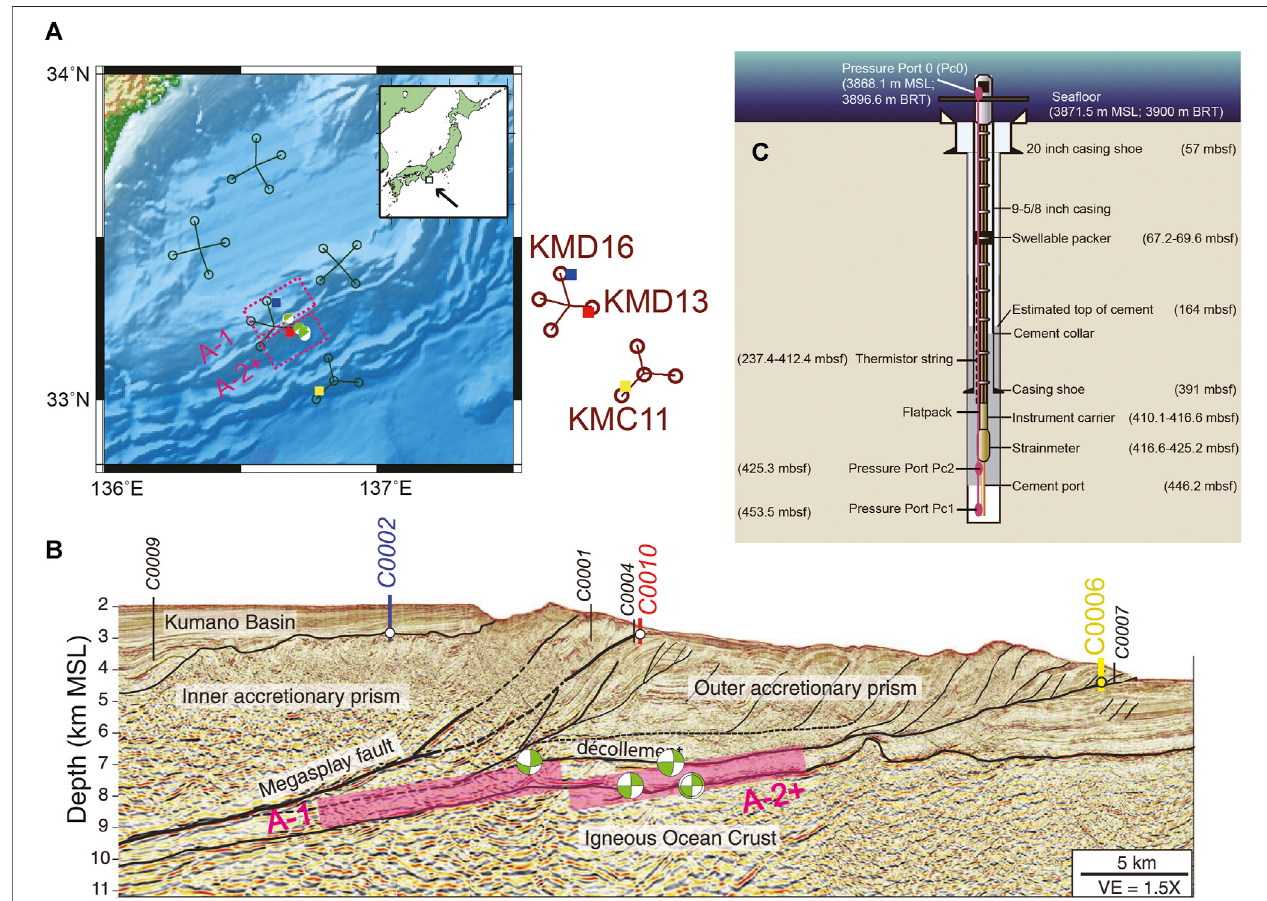
FIGURE 1 | (A) Map of the fault model (A-1, A-2+) of the SSE and sVLFE in March 2020 from previous results (Ariyoshi et al., 2021). Squares represent borehole stations. Labeled names (D-16, D-13, and C-11) are the nearby DONET stations for C0002 (blue), C0010 (red), and C0006 (yellow), respectively. Focal mechanism is obtained from Ariyoshi et al. (2021). (B) Seismic section showing the location of the boreholes C0002 (937 – 980 mbsf), C0010 (610 mbsf), and C0006 (453.5 mbsf), wherembsf (cid:2) meterbelowsea fl oor;VE (cid:2) verticalexaggeration.TheaveragesourcelocationerrorsofsVLFEsare5and2kmforhorizontalandverticalcomponent, respectively (Nakano et al., 2018). Spatial resolution of focal depth and fi xed dip angle for the SSE is 1 km and 6 ° , respectively (Ariyoshi et al., 2021). The focal depths of thefaultmodelsA-1andA-2+areassumedtobeconsistentwithVLFEbecauseitispracticallydif fi culttodeterminethefocaldepthpreciselyfromonlythetwovolumetric straindataatboreholes(C0002andC0010)byusingthesimpli fi edgreen ’ sfunction. (C) Boreholecompletion diagramat C0006.Thesolidmagentaellipsesindicatethe pressuregauges,wherethetopone(Pc0)isahydrostaticreferencepressuresensorusedtoremoveoceanographicsignals,BRT (cid:2) belowrotarytable,andMSL (cid:2) mean sea level. Figures (B,C) are modi fi ed after Figure 1 of Araki et al. (2017) and Figure 2 of Kinoshita et al. (2018), respectively.